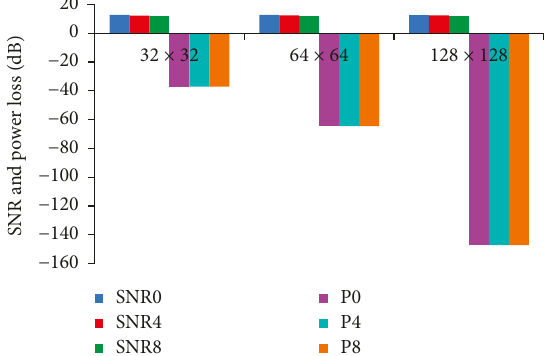
Figure 10: SNR and power loss with different extra channels.